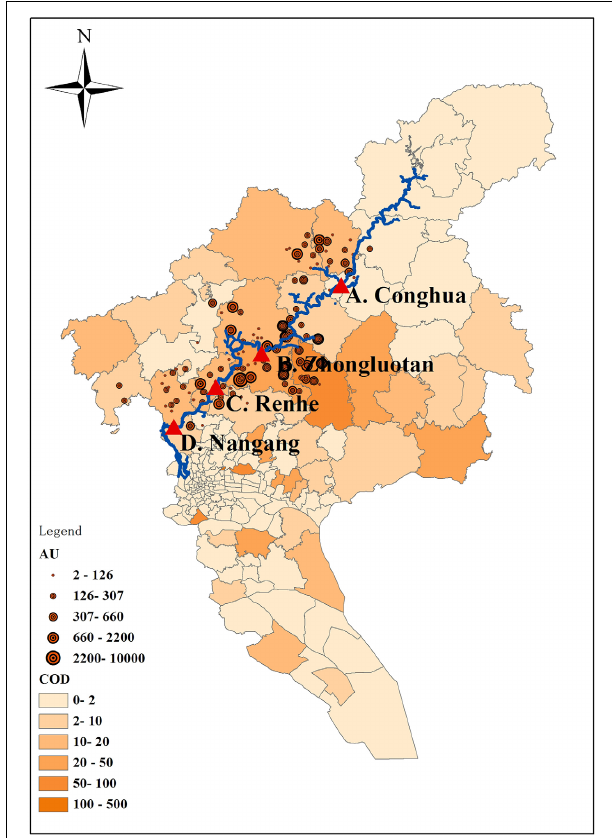
FIGURE 1 | Sampling locations and potential pollution sources. AU, animal unit, equivalent to 454kg animal body weight. COD, Chemical Oxygen